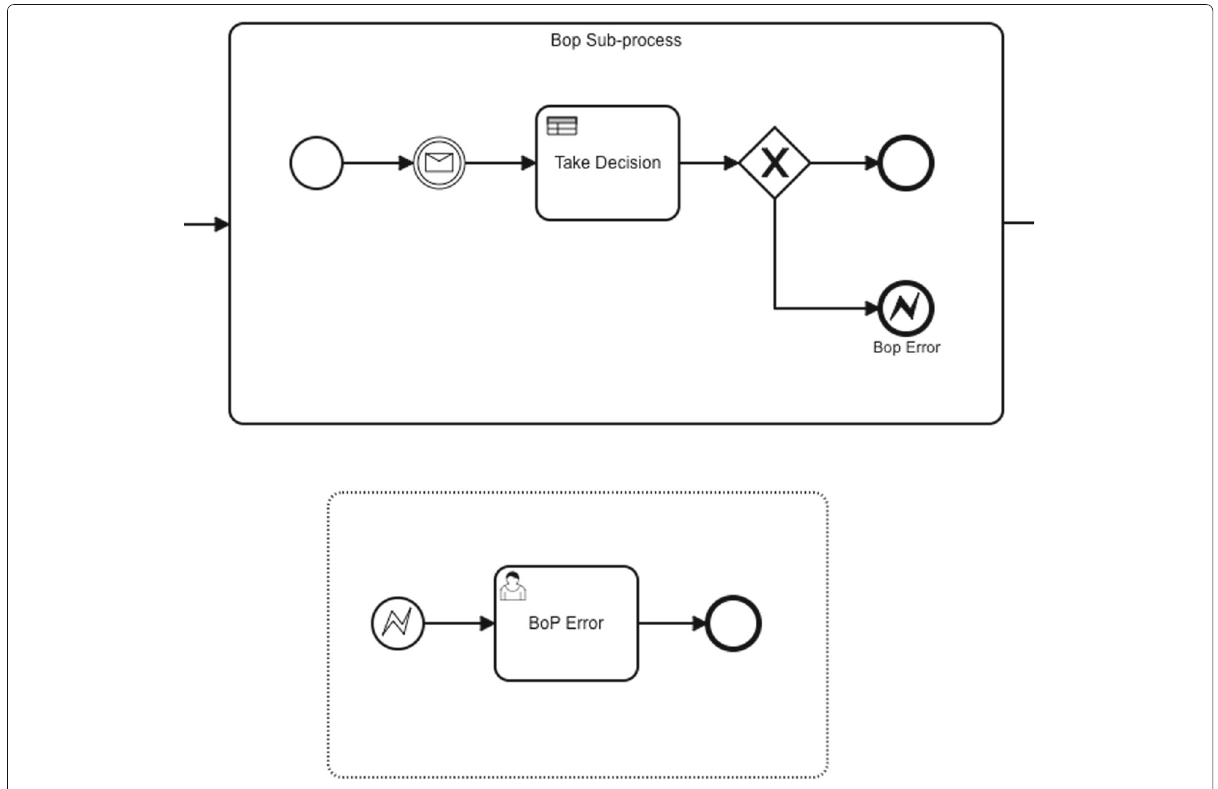
Fig. 17 Implementation of the BoP element